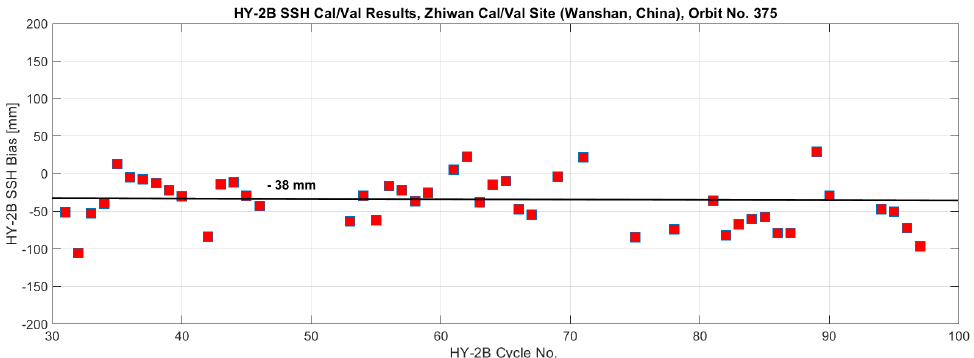
Figure 15. The HY-2B SSH bias as determined by the Wanshan Cal/Val sites in China, using Pass 375. Data cover cycles from No. 31 (January 2020) to No. 97 (July